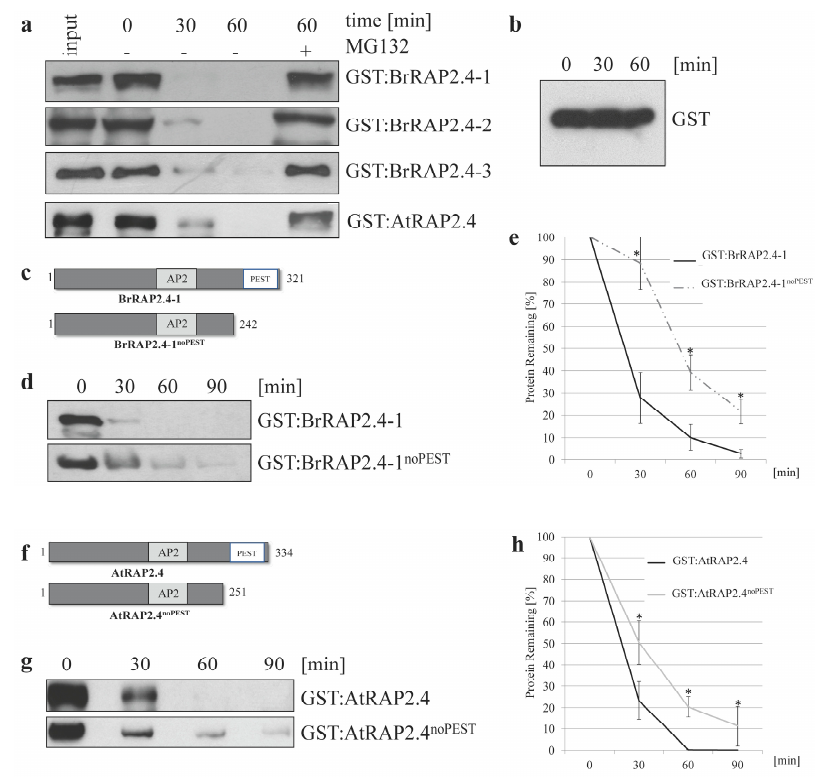
Figure 4. Characterization of protein stability for BrRAP2.4-1, -2, and -3. ( a ) Cell-free